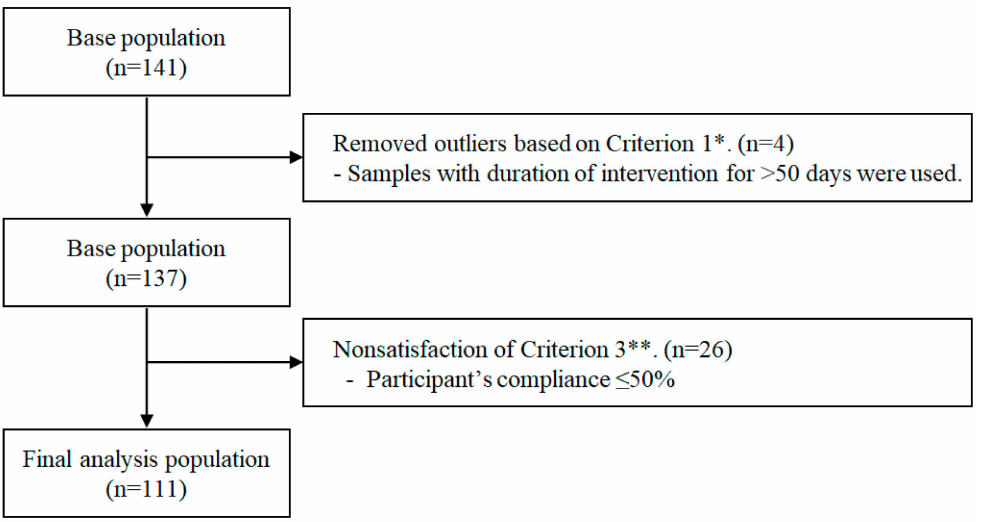
Figure 2. Flow chart of the selection of the study population. * Criterion 1 was defined as the duration of wearing Fitbit ® device between baseline and follow-up. ** Criterion 3 was defined as the participant’s compliance, calculated as the ratio of the day with overtime estimated based on the average duration that the device was worn per day during the